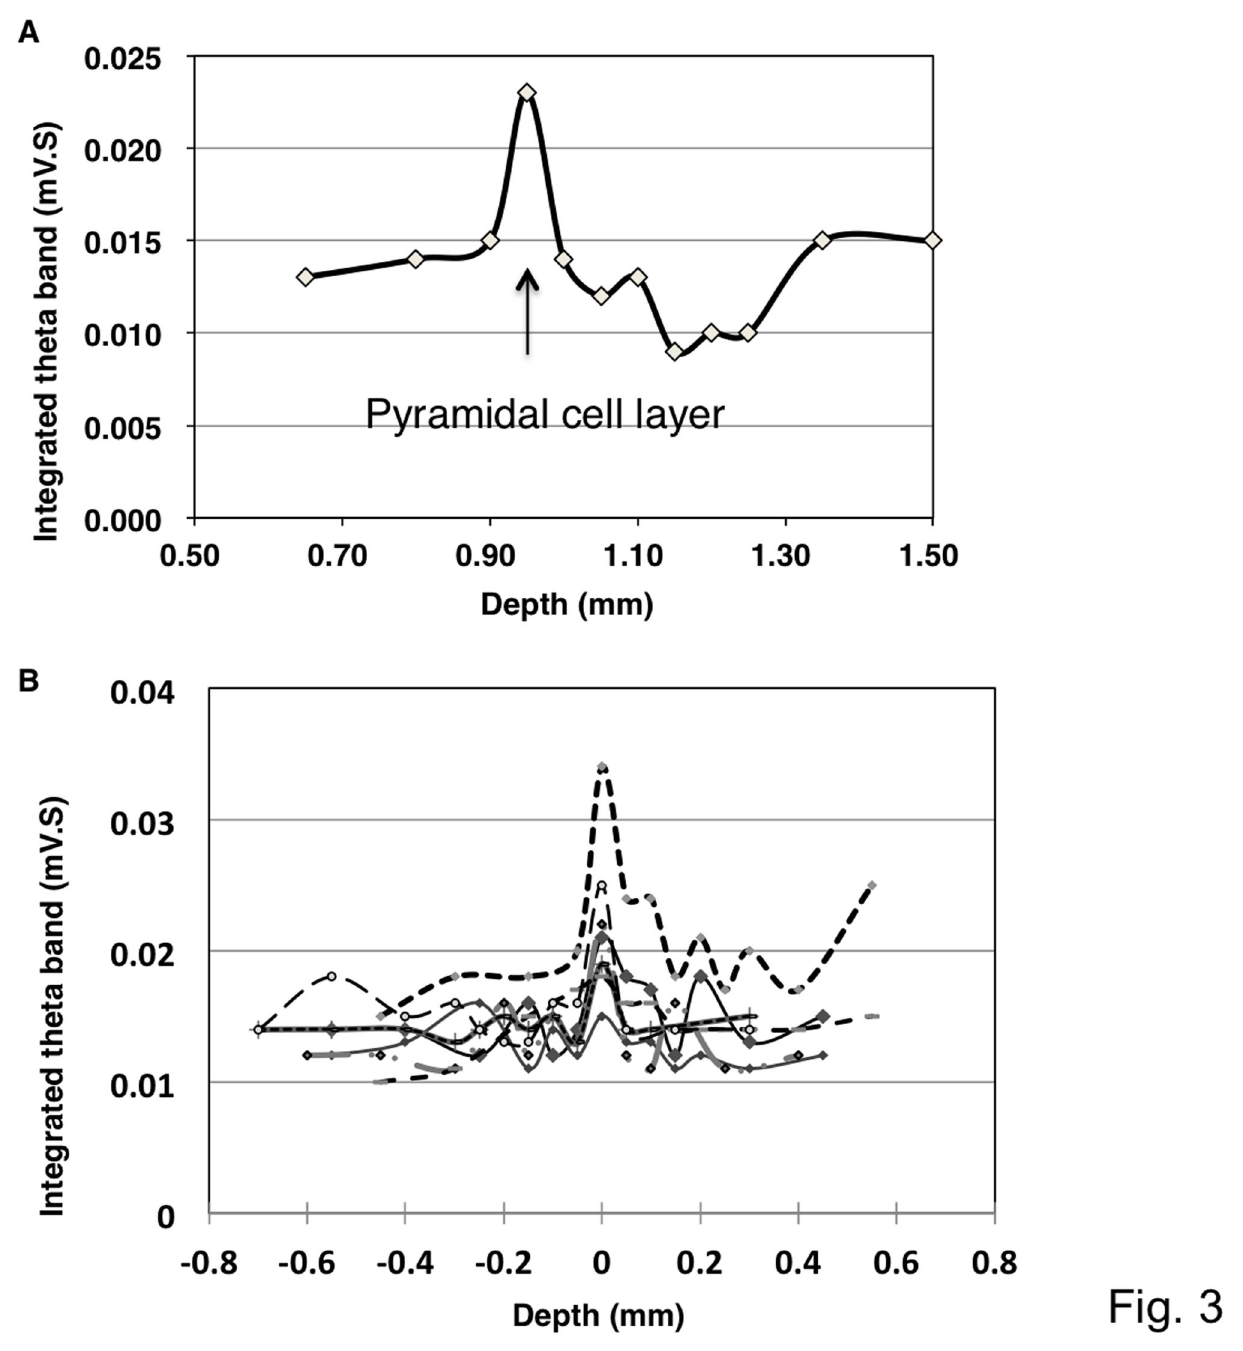
Figure 3. Representative traces showing changes in the integrated value of the theta oscillation at different depths. A . A theta oscillation integrated over 0.5 sec indicated the highest value presumably in the pyramidal layer of the hippocampus. After the first peak, the value declined towards the bottom of the stratum radiatum and then increased again. B . Superimposition of the integrated values of the theta oscillation. The changes in the integrated values across seven independent experiments were superimposed. All of the data presented a similar pattern of peaks, and these peaks overlapped at a point that was assumed to be the CA1 pyramidal